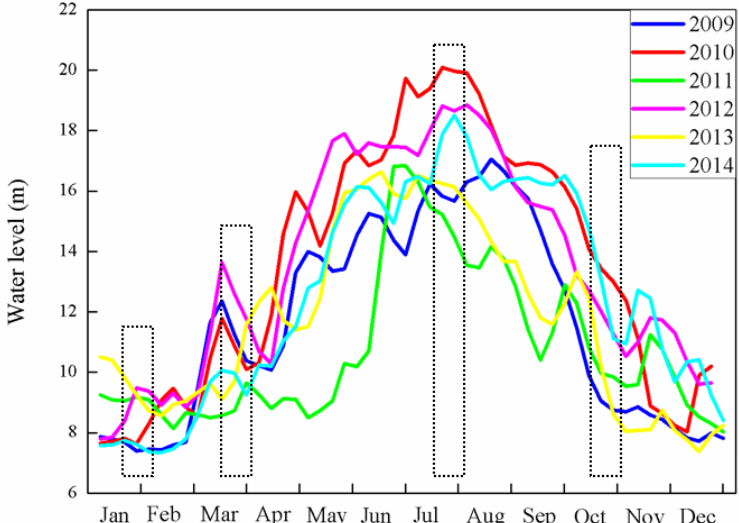
Figure 2. Water level variations of Poyang Lake from 2009 to 2014 (the dashed squares represent the sampling duration).